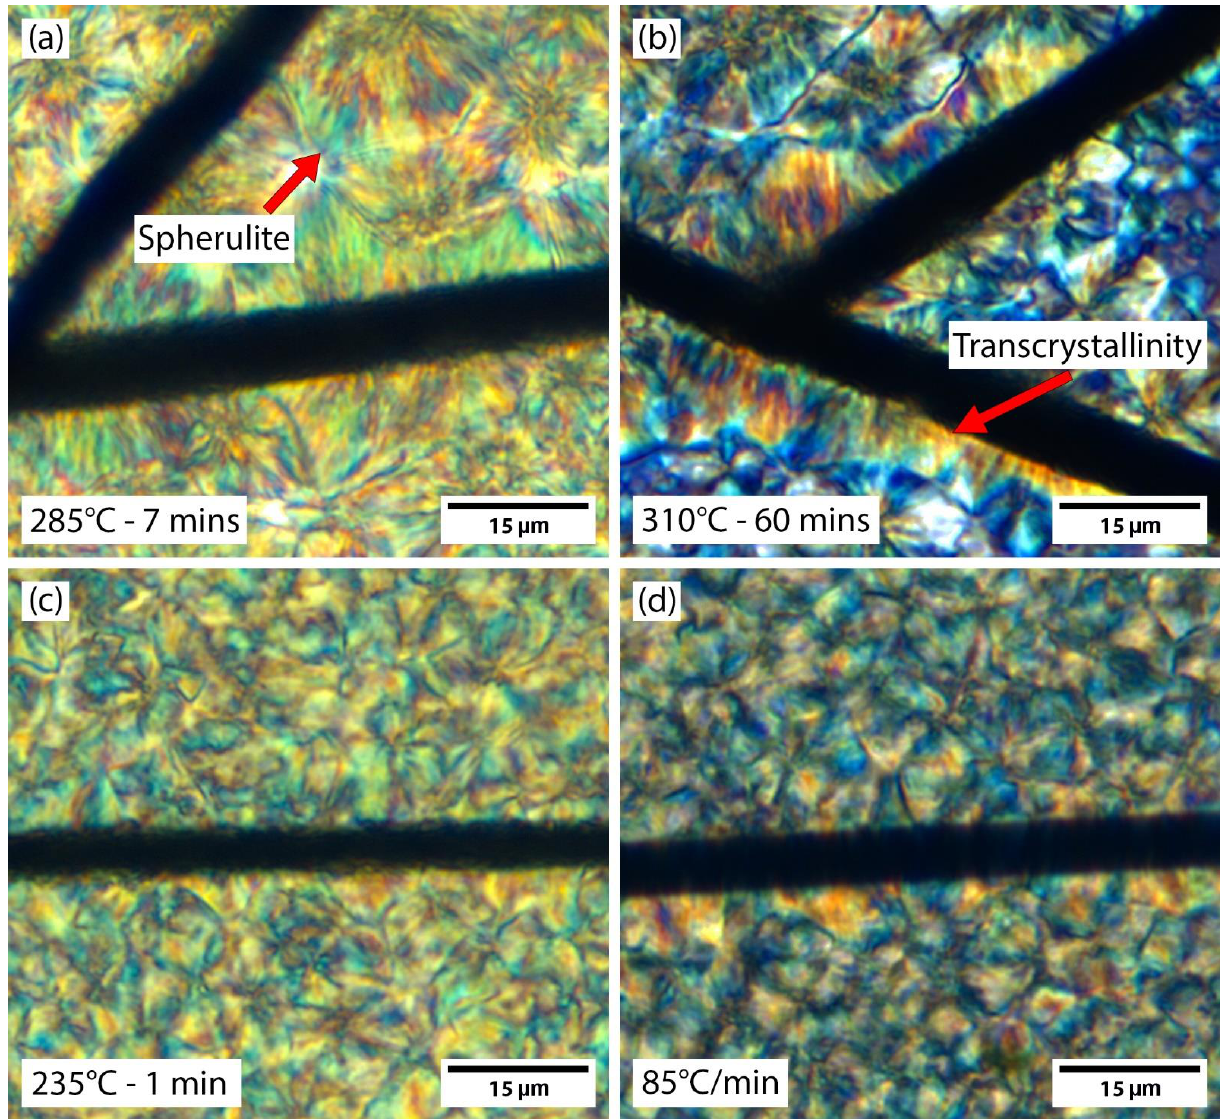
Figure 5. Morphology changes in each process. ( a ) a 285 °C isothermal dwell produces larger transcrystalline regions and large spherulites. An example spherulite is identified. ( b ) the 310 °C dwell produces the largest spherulites and transcrystalline regions. An example transcrystalline region is identified. ( c ) a 235 °C dwell produces minor transcrystalline growth and small spherulites that do not resolve in PLM. ( d ) an 85 °C/min cooldown shows minimal transcrystalline growth and spherulites do not resolve.